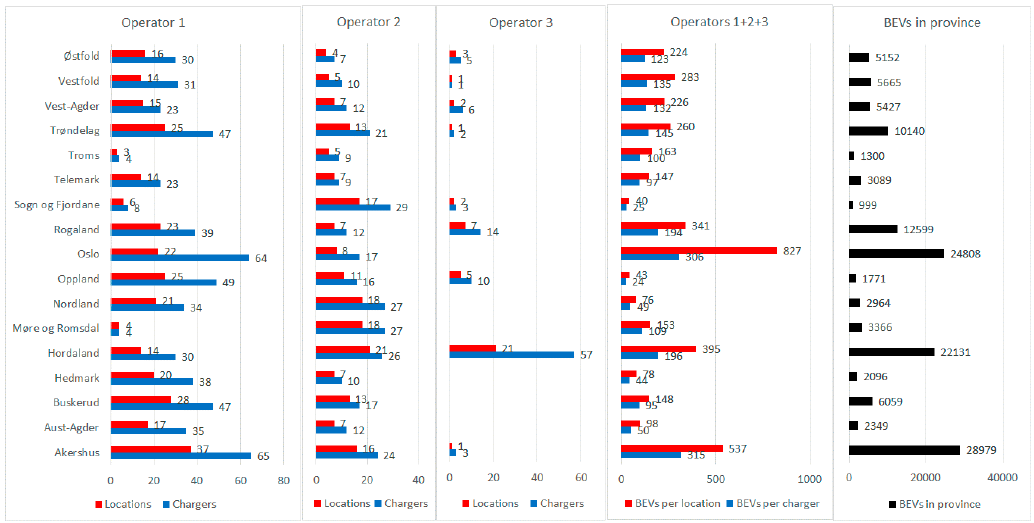
Figure 6. Geographical distribution (Counties) of fast charger locations and total number of fast chargers for the three main operators, and the number of vehicles in the fleet. Vehicle fleet size status 01.01.2018 [34], charge stations status per Q1 2018 (status Q3 for operator 3, as Q1 status was not available). Source: Dataset 1, Dataset 2, Dataset 4. Operator 3 data extracted from operator’s web